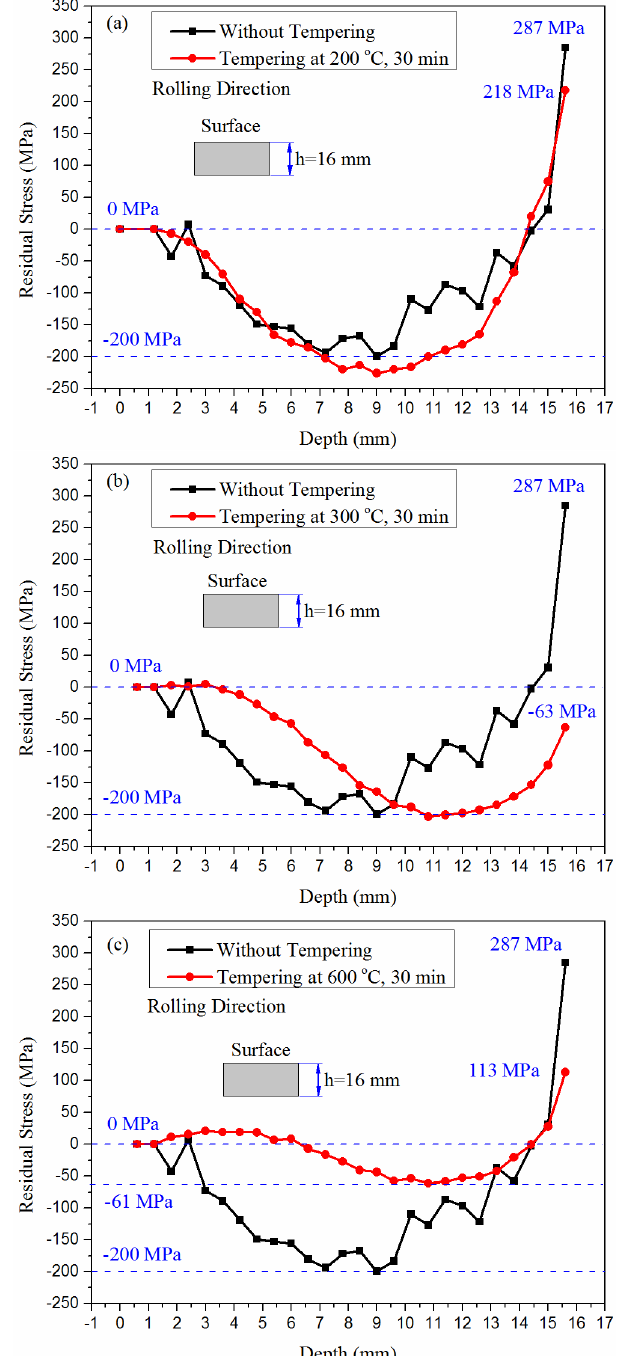
Figure 7. Comparisons of residual stress distribution before tempering of 700 L with that after tempering at 200 ◦ C, 300 ◦ C, and 600 ◦ C for 30 min. ( a ) Tempering at 200 ◦ C for 30 min; ( b ) Tempering at 300 ◦ C for 30 min; ( c ) Tempering at 600 ◦ C for 30 min.